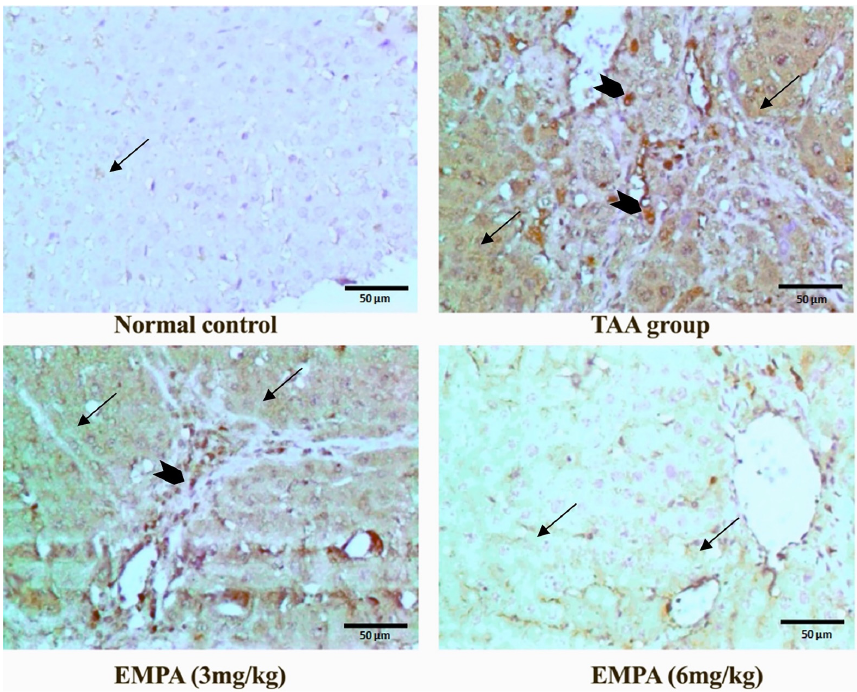
Figure 7. Photomicrographs of histopathology sections stained with immunohistochemical caspase-3 antibody. Control group was minimally stained mainly sinusoidal (thin arrow), with strong diffuse cytoplasmic stain (thin arrows) in hepatocytes with occasional nuclear staining in the portal area (arrow heads) in the toxic group; insignificant changes in comparison to the toxin group with strong diffuse hepatocyte cytoplasmic (thin arrows) and occasional nuclear staining (arrow head) in the portal area in 3 mg group; minimal positive staining restricted to the sinusoidal surface (thin arrows), no hepatocyte expression in 6 mg group (magnification = 400×).